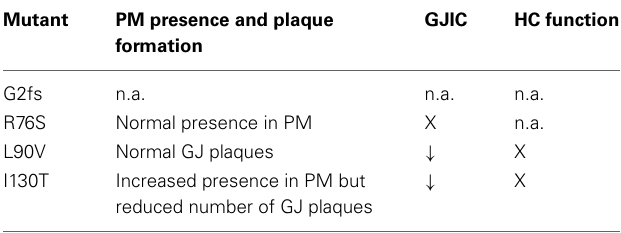
Table 2 | List of ODDD-linked mutations associated with epileptic seizures and their effect on Cx43 HCs and